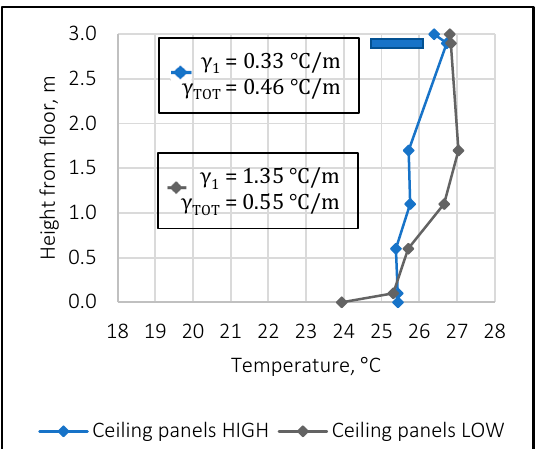
Figure 9. Measured temperature gradient of underfloor cooling ( a ) and fan coil unit ( b ).